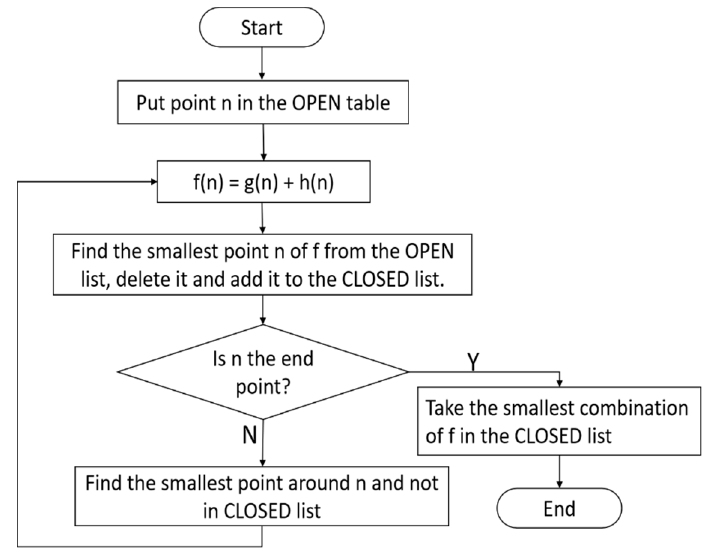
Figure 12. A-Star Algorithm.